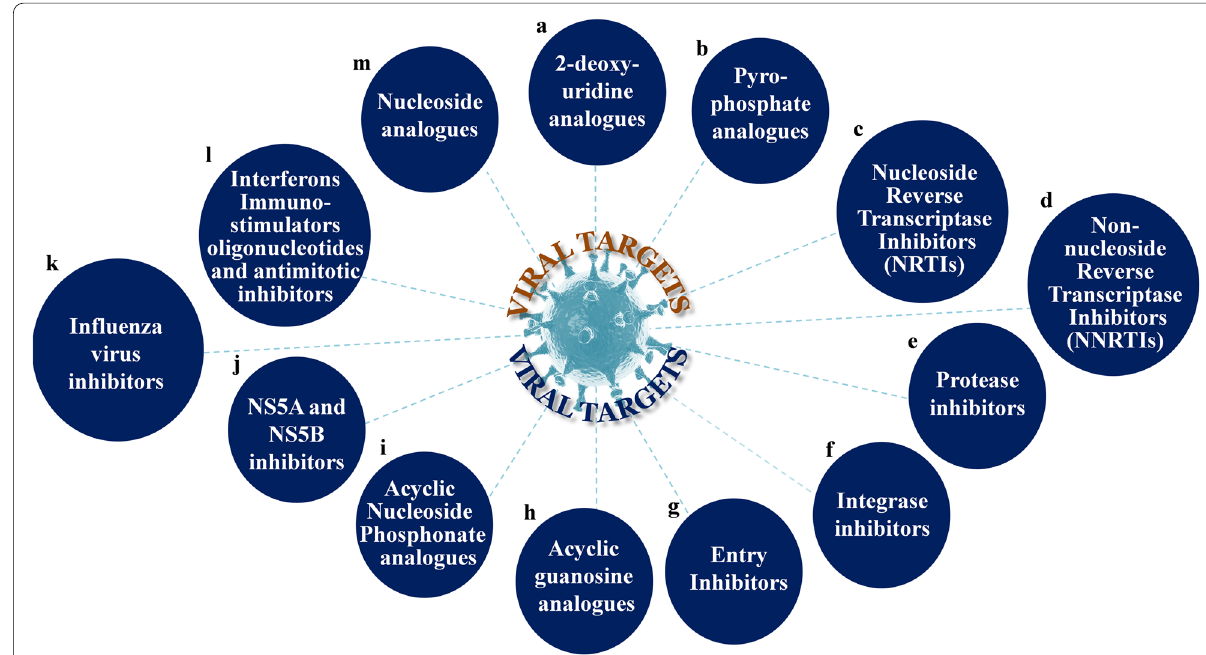
Fig. 2 Illustrative lists of approved antiviral drugs (90) in different drug groups (13) against such nine human viruses including a 2-Deoxyuridine analogues: Idoxuridine, Vidarabine, Trifluridine, Brivudine, Entecavir, Telbivudine, Clevudine; b Pyrophosphate analogues: Foscarnet; c Nucleoside Reverse Transcriptase Inhibitors (NRTIs): Zidovudine, Didanosine, Zalcitabine, Stavudine, Lamivudine, Abacavir, Lamivudine Zidovudine, + Abacavir Lamivudine Zidovudine, Emtricitabine; d Non-Nucleoside Reverse Transcriptase Inhibitors (NNRTIS): Nevirapine, Delavirdine, Efavirenz, + + Etravirine, Etravirine, Rilpivirine; e Protease Inhibitors: Saquinavir, Ritonavir, Indinavir, Nelfinavir, Amprenavir, Lopinavir-Ritonavir, Atazanavir, Fosamprenevir, Tipranavir, Darunavir, Boceprevi; f Integrase Inhibitors: Raltegravir, Elvitegravir, Dolutegravir, Dolutegravir abacavir Lamivudine, + + Dolutegravir lamivudine; g Entry Inhibitors:VZIG Human Varicella-Zoster immune Globulin, RSV-IGIV, Respiratory lsyscytia virus, immunue + globulin Intravenous,Palivizumab, Docosanol, Enfuvirtide, Maraviroc, VariZig; h Acylic Guanosine Analogues: Acyclovir, Ganciclovir, Famciclovir, Valacyclovir, Penciclovir, Valganciclovir; i Acylic Nucleoside Phosphonate Analogues: Cidofovir, Adefovir dipivoxil, Tenofovir disoproxil fumarate, Tenofovir disoproxil fumarate Emtricitabine, Tenofovir disoproxilfumarate Emtricitabine efavirenz, Tenofovirdisoproxil + + + fumarate Emtricitabine elvitegravir, cobicistat, Tenofovir disoproxil fumarate Emtricitabine elvitegravir cobicistat, Tenofovir disoproxil + + + + + fumarate cobicistat Emtricitabine elvitegravir, Tenofovir adafenamide Emtricitabine, Rilpivirine Tenofovir adafenamide Emtricitabine, + + + + + + Tenofovir Alafenamide Fumarate Emtricitabine, Grazoprevir; j NS5A and NS5B Inhibitors: Sofosbuvir Ribavirin, Sofosbuvir Ribavirin pegIFNα, + + + + Daclatasvir Asunaprevir, Daclatasvir Daclatasvir Sofosbuvir, Daclatasvir Simeprevir, Dasabuvir, Omibitasvir dasabuvir paritaprevir ritonavir, + + + + + + Ledipasvir Sofosbuvir, Omibitasvir paritaprevir Ritonavir, Daclatasivir Sofobuvir, Elbasvir Grazoprevir; k Influenza Virus Inhibitors: + + + + + Amantadine, Ribavirin, Rimantadine, Zanamivir, Oseltamivir, Favipiravir, Laninamivir, Peramivir; l Interferons Immunostimulators, Oligonucleotides and Antimitotic Inhibitors: Pegylated interferons a, lfa 2b, Interferon alfacon-1, Imiquimod (INN), Pegylated interferons, alfa- 2b ribavirin, + Fomivirisen, Peginterferon, Alfa-2a, Sinecatechins; m Nucleoside Analogues: Vidarabine, Entecavir, Telbivudine, Telaprevir, Boceprevir, Simeprevir, Asunaprevir, Vaniprevir Ribavirin Peg-IFNα-2b, Paritaprevir, Asunaprevir, Darunuvir Cobicistat, Atazanavir cobicistat + + + + +